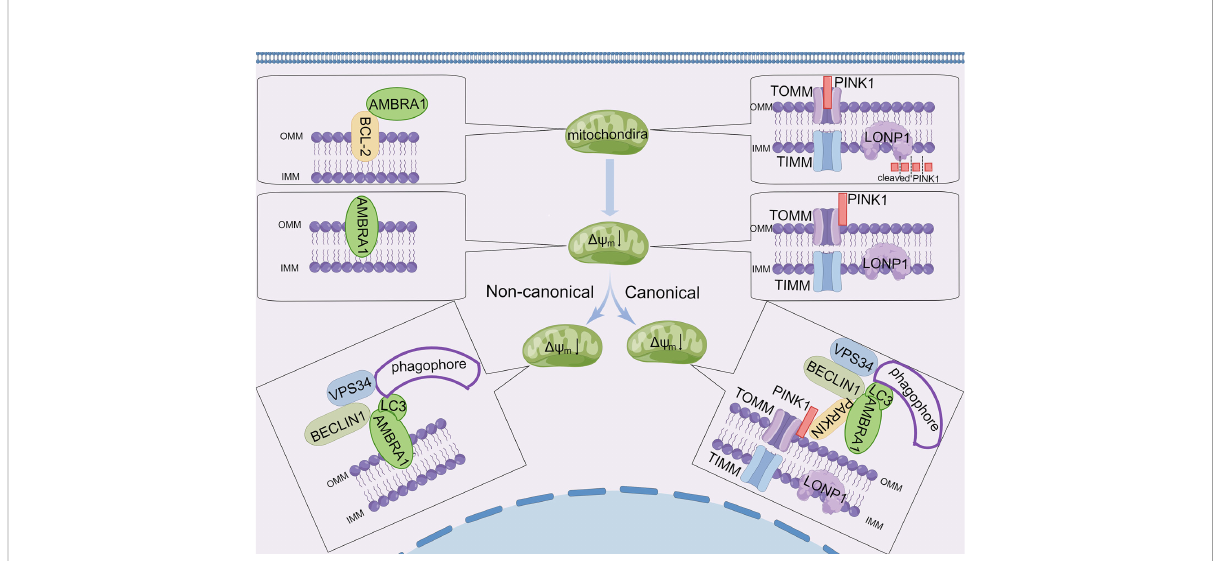
FIGURE 3 AMBRA1 and canonical/non-canonical mitophagy. Under normal conditions, AMBRA1 interacts with BCL-2 at the outer mitochondrial membrane. PINK1 is transported to the inner mitochondrial membrane through the TOM/TIM complex, and then PINK1 is damaged by LONP1. Upon loss of mitochondrial membrane potential ( Dy m), AMBRA1 separates with BCL-2 and relocates to OMM. PINK1 accumulates on the outer membrane surface where it associates with the TOM complex. AMBRA1 promotes mitophagy of damaged mitochondria in two major ways: i) in non-canonical mitochondrial clearance, AMBRA1 functions as a mitophagy receptor and accumulates on the OMM, promoting speci fi c binding to LC3 through a conserved LC3-interacting region (LIRs) and regulating the formation of phagophore enclosing mitochondria. ii) In canonical mitochondrial clearance, the accumulation of PINK1 recruits cytosolic PARKIN and AMBRA1, which induces new phagophores through its effect on VPS34 and its